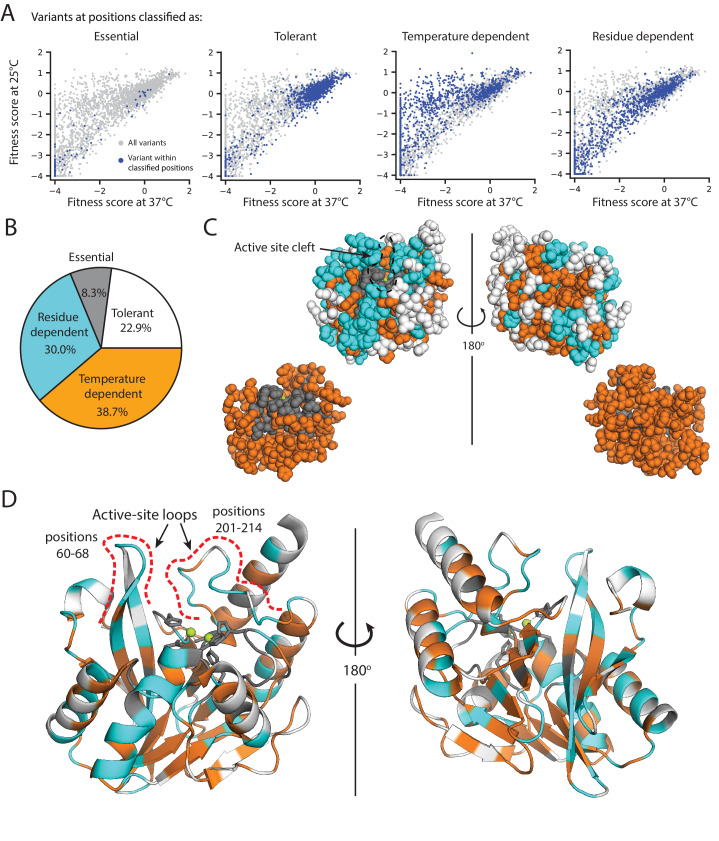
Distribution of mutational tolerance and temperature dependence of wtVIM-2 residues.(A) Scatterplots comparing fitness scores under selection at 25°C and 37°C (128 µg/mL AMP). Variants within the classified positions are highlighted in dark blue while all variants are plotted in grey for reference. (B) Proportion of residues in the wtVIM-2 catalytic domain that have been classified into each behavioral category. (C–D) The wtVIM-2 crystal structure (PDB: 5yd7) is colored by the behavioral classifications, the active-site zinc ions are colored in lime green. (C) View of the spacial distribution of temperature dependence in wtVIM-2, with residues depicted as spheres. The upper row depicts all residues, while the lower row depicts only essential and temperature dependent residues. (D) Cartoon representation of wtVIM-2 with metal-binding residues shown as sticks. All classifications can be found in Supplementary file 2F. Additional analysis of temperature dependence can be found in Figure 6—figure supplement 1 (correlation of Rosetta ΔΔG with temperature dependence) and Figure 6—figure supplement 2 (proportion of sidechain-backbone hydrogen bonding by temperature dependence).